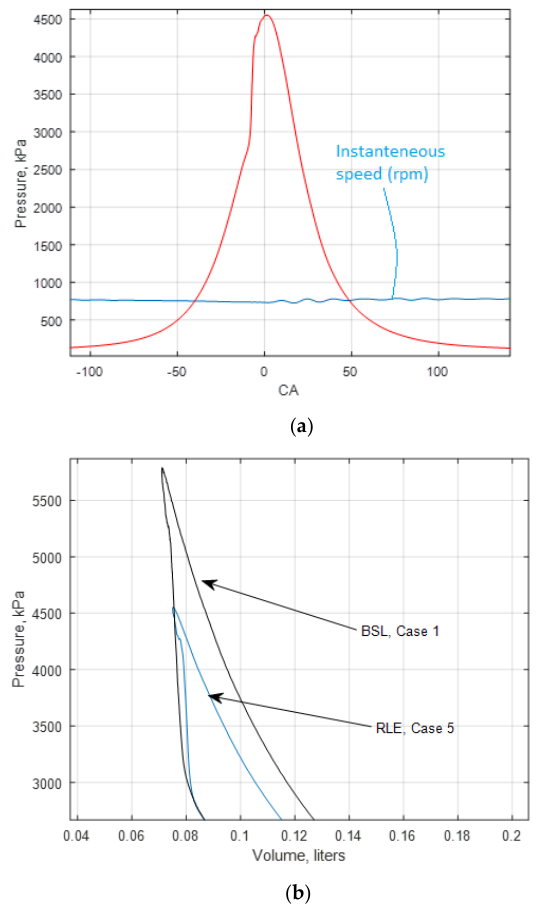
Figure 12. ( a ) One case of RLE combustion characteristics that matches well the BSL and lacks the pressure wave noise. ( b ) Top of P-V diagram for the RLE case, also identical to BSL in Figure 11. Unlike Figure 11, the proper clearance volume is now used for the BSL graph.